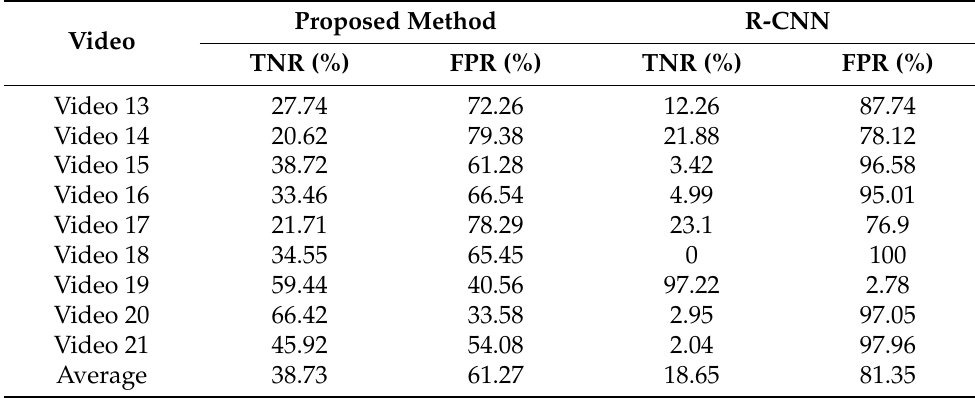
Table 6. Comparison of TNR and FPR Results on FireSense Dataset